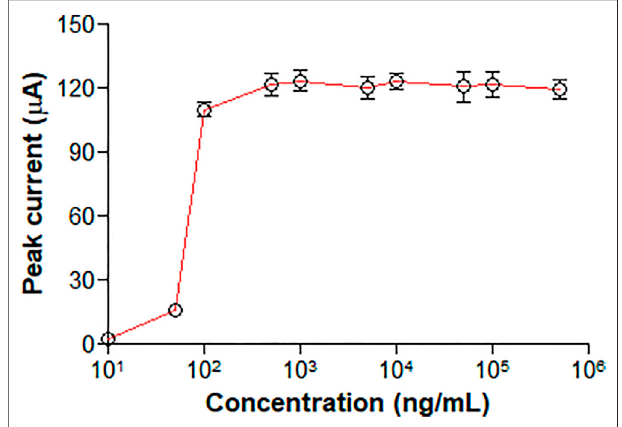
FIGURE 3 | Representation of peak current over a concentration range from 10 to 500,000 ng/ml